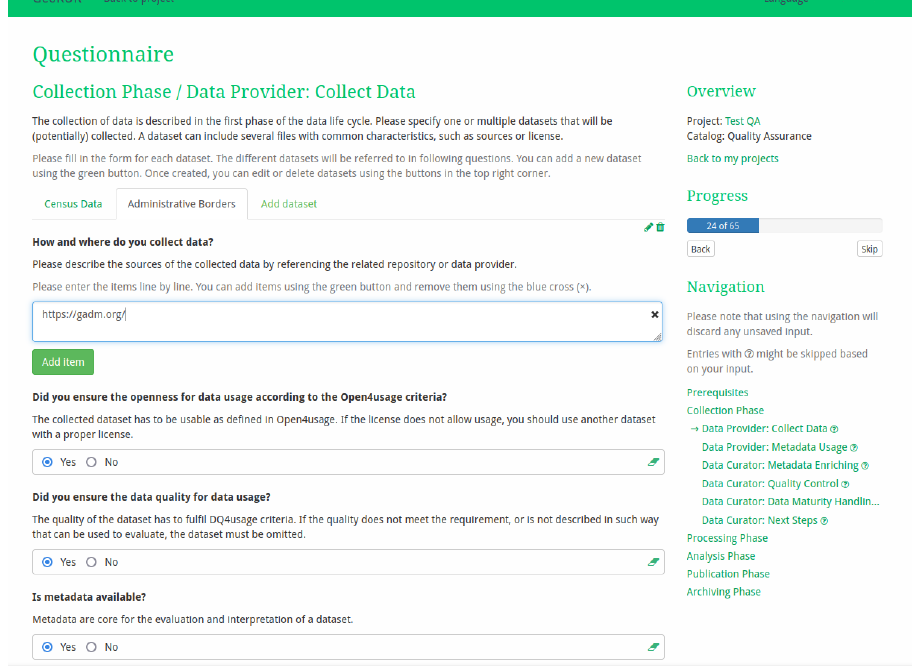
Figure 6. Implementation of the QA workflow as an RDMO questionnaire.